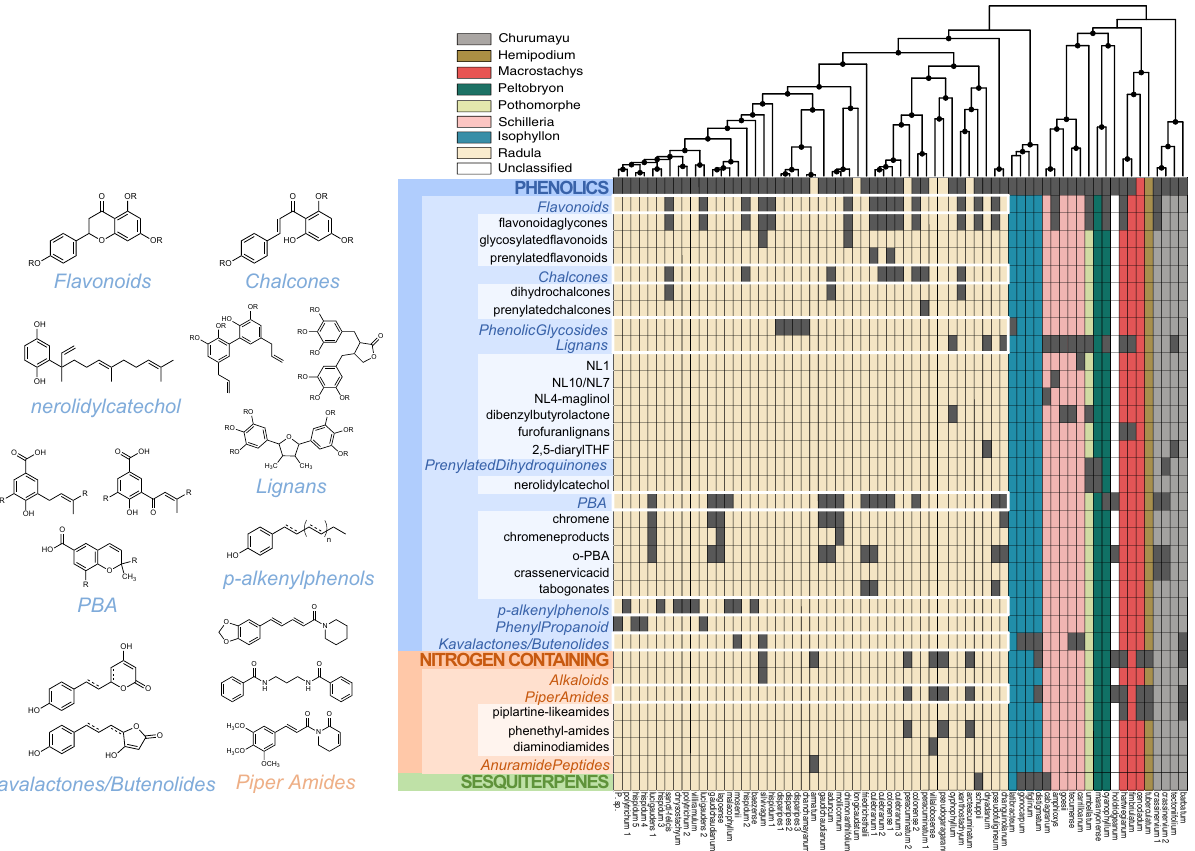
Figure 2. Patterns of chemical variation are displayed for individuals in this study. Taxa comprise the columns of the matrix and are ordered according to their inferred phylogenetic relationships. Groups of columns are colored according to their designated Piper clade. Black circles within the phylogenetic tree designate nodes with posterior support values greater than 85%. Each row of the matrix represents a metabolite class that was detected from 1 H NMR and MS-based methods, and dark grey cells indicate the presence of that class in that taxa. Classes are hierarchically nested; capitalized font signifies the three classes at the highest level (and coarsest resolution), italicized font signifies the intermediate level, and black font signifies the lowest level (and highest resolution). Rows outlined in white indicate traits that were analyzed for phylogenetic signal in Radula. To the left of the matrix are representative compounds for a subset of metabolite classes that were detected in our